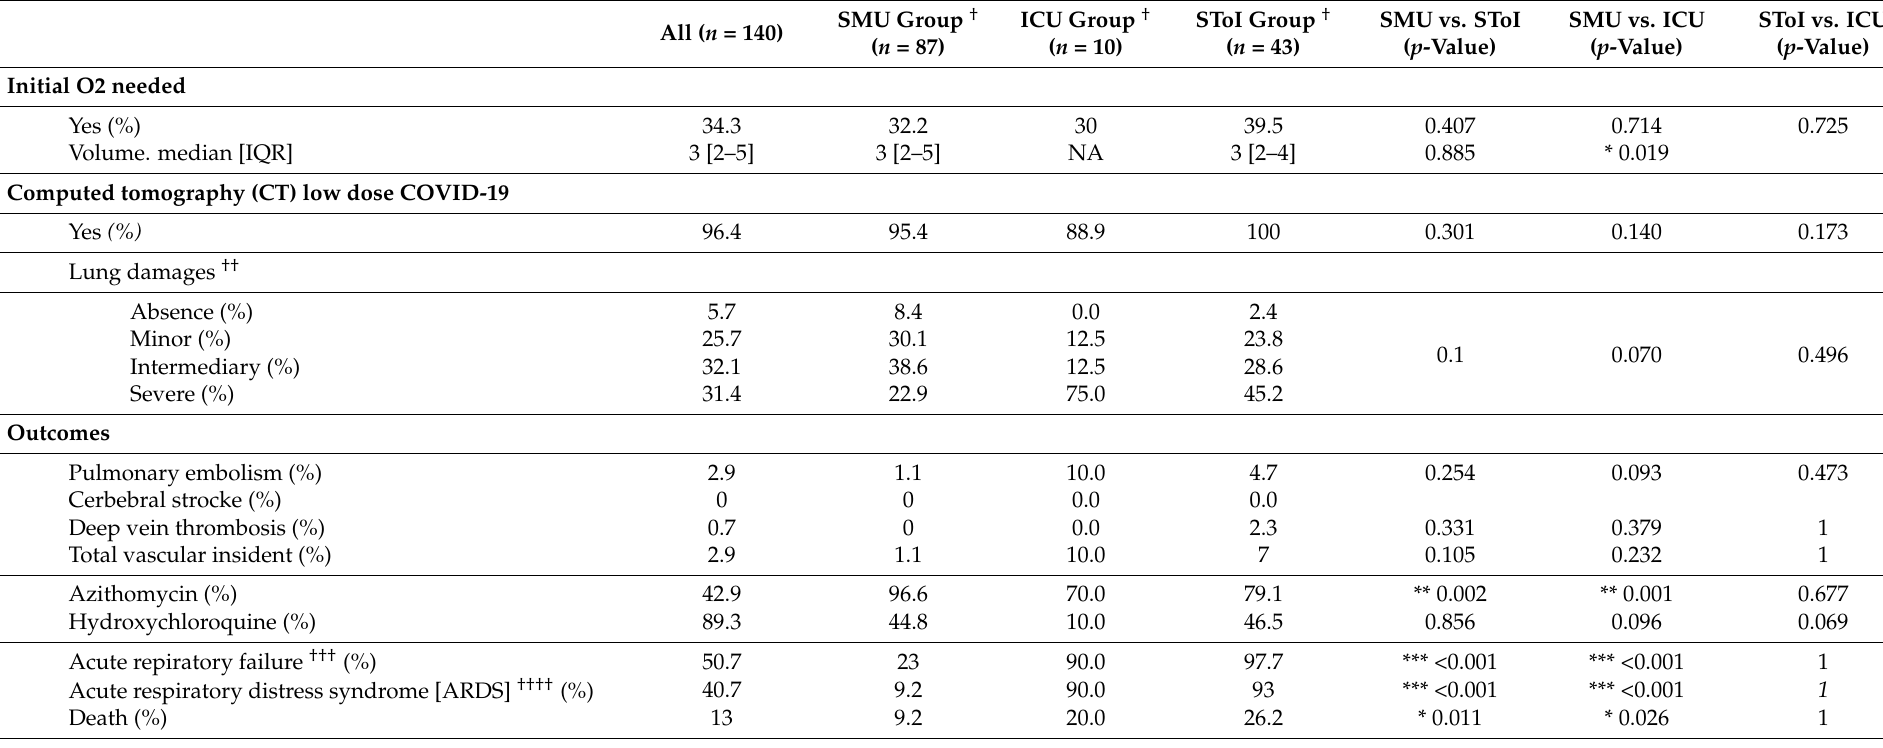
Table 4. Population’s characteristics (demographics data, important timelines, initial vital sign, income data, comorbidities, outcome data); comparison between groups for validation cohort. Parameters with a p -value < 0.05 have significative differences between groups compared. ††† Acute respiratory failure (ARF) was defined as Respiratory rate > 20 (or accessory muscle use for ventilation), and hypoxemia (PaO 2 less than 60 mm Hg on breathing room air). †††† Acute respiratory distress syndrome (ARDS): Acute respiratory failure not explained by cardiac failure or fluid overload with bilateral lung opacities on chest imaging and PaO 2 /FiO 2 < 300 with positive end-expiratory pressure > 5 cm H 2 O [20]. †† Radiological lung damage severity was defined as Minor when patients had 3 compromised sites, with 3 lobules affected on each site (maximum 9 lobules), Intermediary, when patients had a minimum of 10 lobules affected, but less than 50% of total segmental volume, and Severe, when more than 50% of total segmental volume was affected. † SMU group: patients only admitted to Standard Medical Unit, ICU group: patients directly admitted to Intensive Care Unit, SToI group: patients transfered from Standard medical unit to Intensive care unit * p < 0.05; ** p < 0.01; *** p <